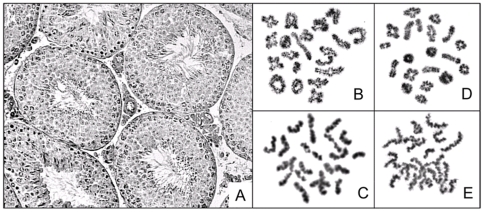
Meiosis in male Mcph1gt/gt germ cells.(A) Section of a testes biopsy from a male Mcph1gt/gt showing normal morphology, (B) diakinesis/metaphase I from a male Mcph1gt/gt reveals normal pairing of the autosomal bivalents and the sex chromosomes (XY), (C) normal metaphase II cell from a male Mcph1gt/gt. For comparison a diakinesis/metaphase I (D) and a metaphase II cell (E) from a male wt/wt mouse are presented.